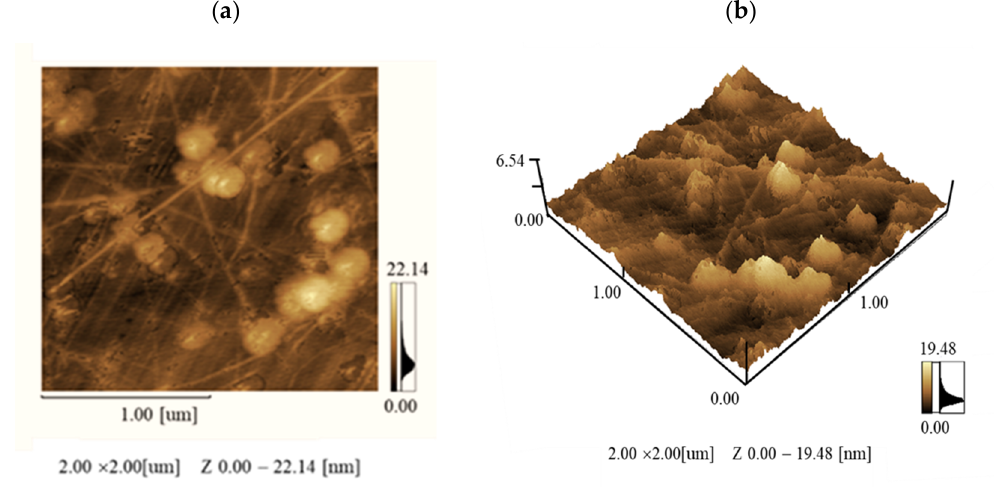
Figure 1. ( a ) 2D- and ( b ) 3D-AFM images of the SWCNT pre-coated quartz glass substrate,